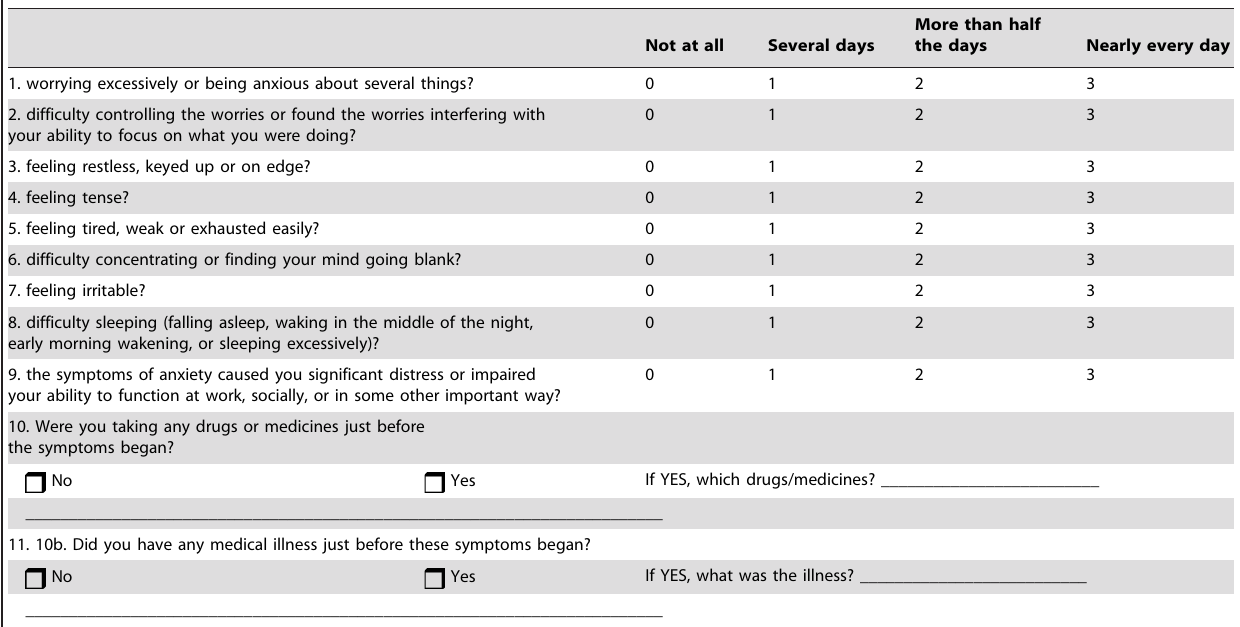
Over the last 6 months, how often have you been bothered by any of the following